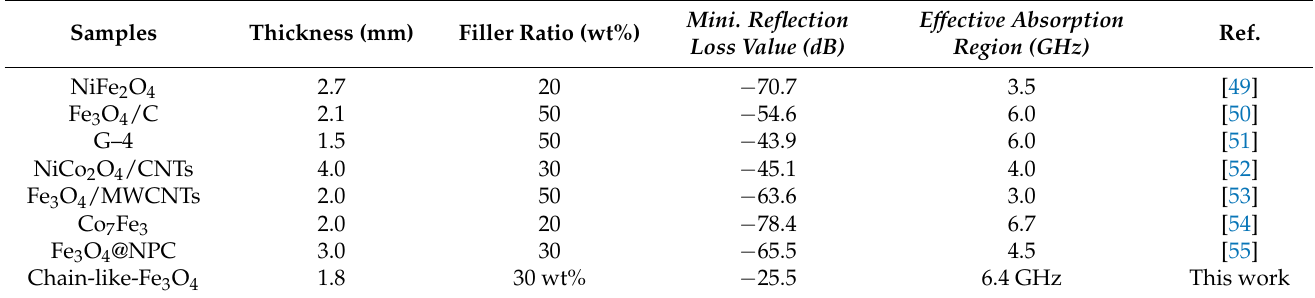
Table 1. Ferrites based electromagnetic absorption performance according to recent